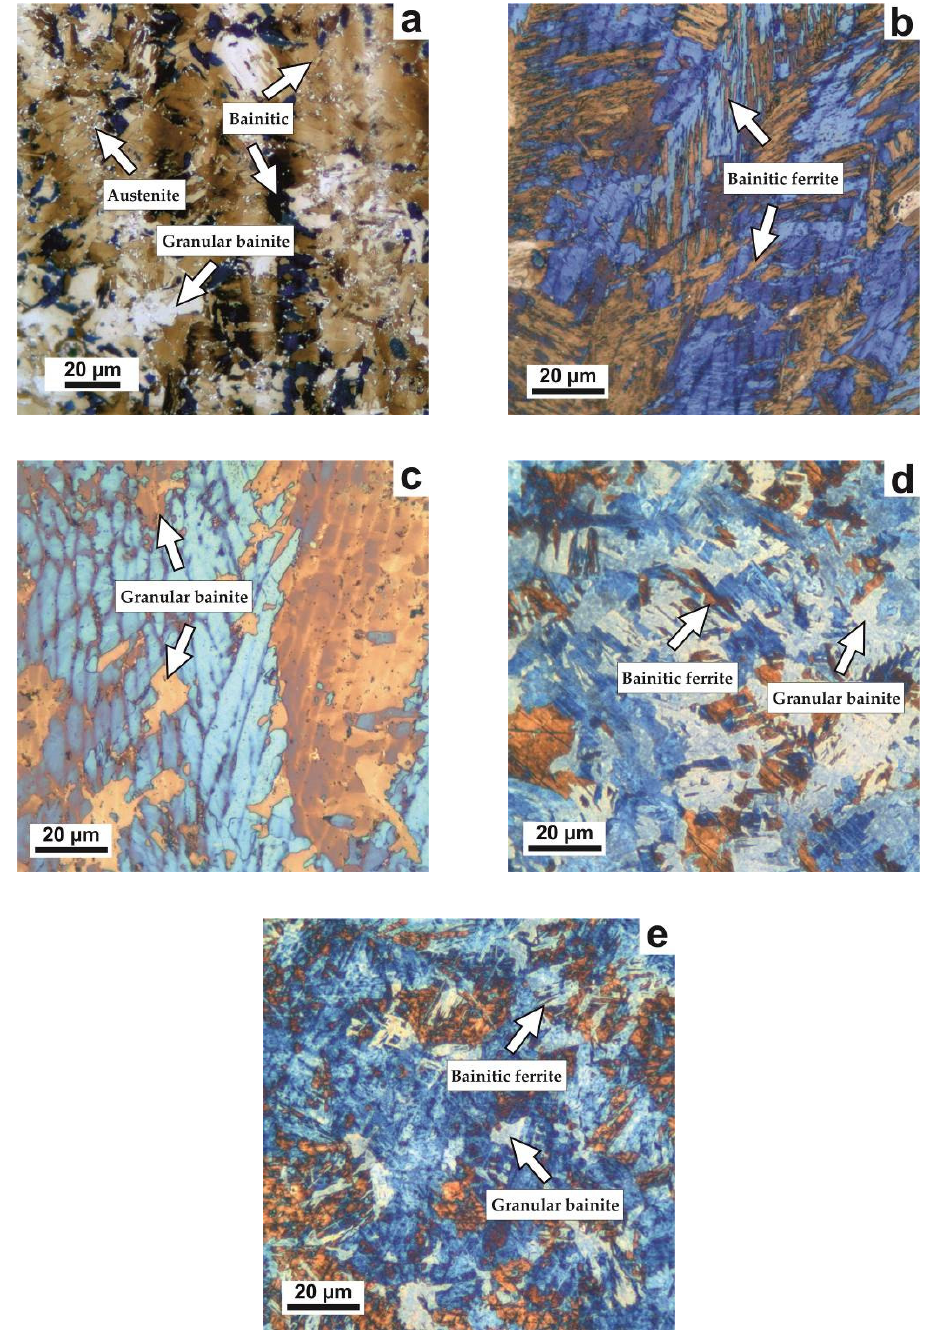
Figure 3. Microstructure of 09CrNi2MoCu steel in various states: ( a ) rolled products; ( b ) Т 1 (steel in initial state after DLD); ( c ) Т 2 (DLD+HT); ( d ) Т 3 (DLD+HT); ( e ) Т 4 (DLD+HT).